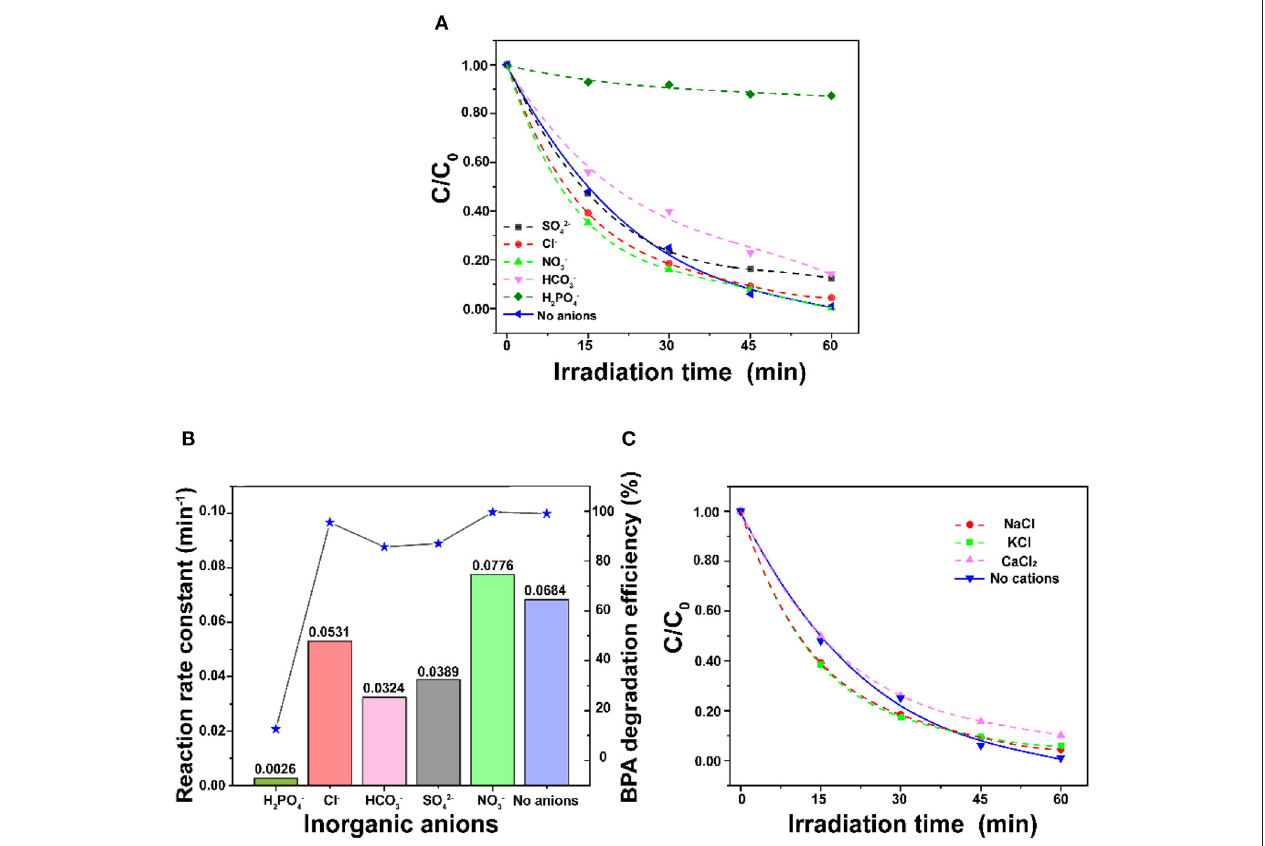
FIGURE 7 | (A) Comparison of different inorganic anions on the degradation of BPA, (B) Effect of inorganic anions on the reaction rate constant, and (C) Comparison of different inorganic cations on the degradation of BPA (BPA concentration = 30 mg/L and ZnO dosage = 1 g/L).